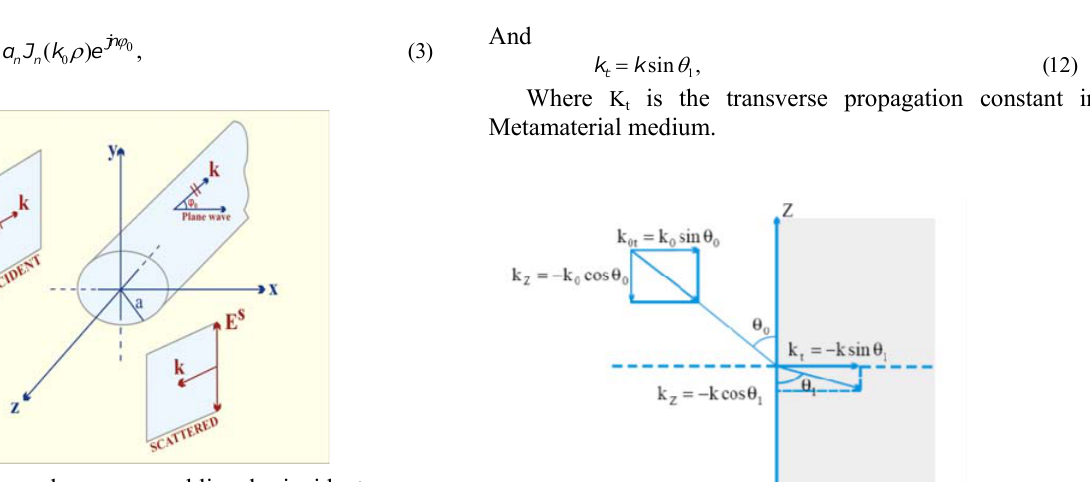
Figure 2: Uniform plane wave obliquely incident on a metamaterials cylinder: TM z polarization.